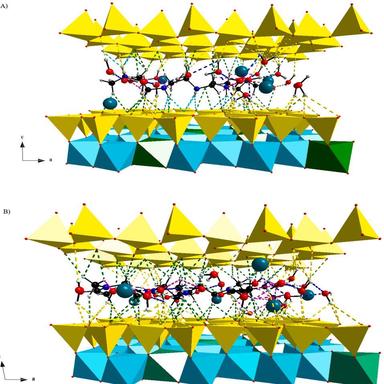
The hydrogen bonds in the structures of A) PEI-Mt and B) PMeOx-Mt; green (Cp–Hp⋅⋅⋅Ob), magenta (Cp–Hp⋅⋅⋅Ow), blue (Ow–Hw⋅⋅⋅Ow), yellow (Ow–Hw⋅⋅⋅Ob), red (Ow–Hw•••Np), cyan (Np–Hp•••Ob). (Cp, Hp, Np – carbon, hydrogen and nitrogen of polymer; Ob – basal oxygen of the tetrahedral sheet; Ow – oxygen of H2O).